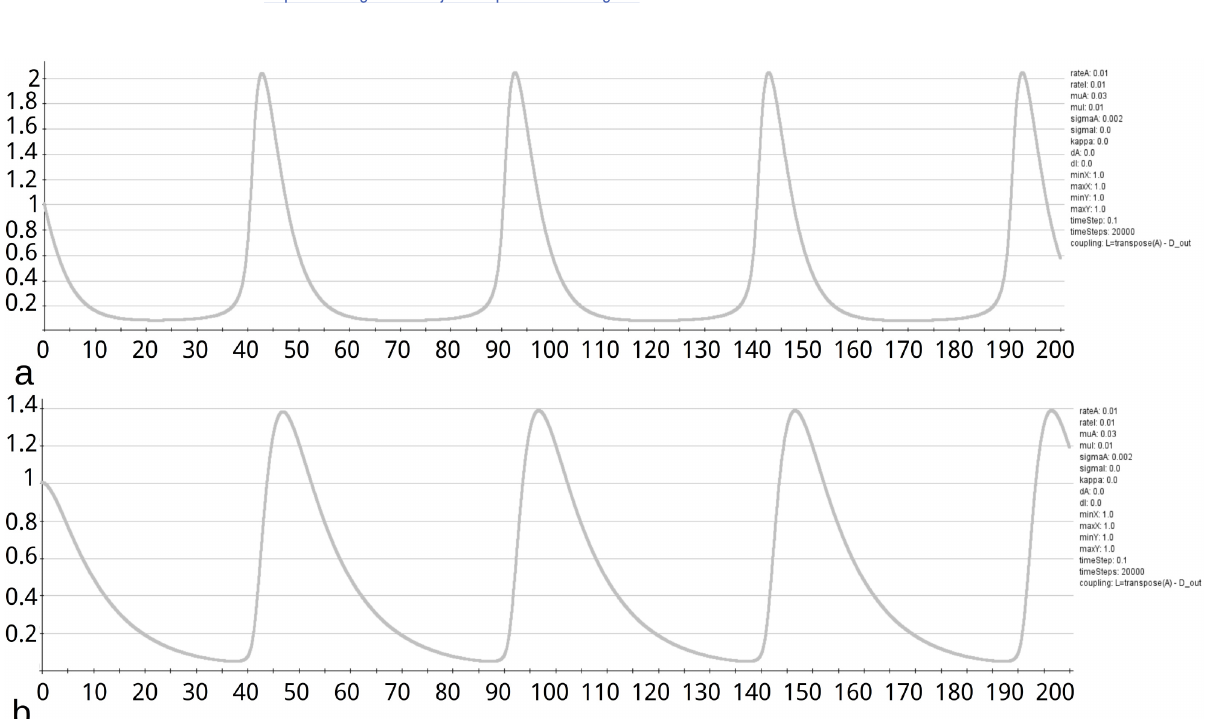
Fig 18. Oscillations of functions u and v . a) In addition to the stability of the function u in Fig 16 the regularity of the oscillations shall be shown here. The regularity extends over all performed iterations. b) The regularity of the oscillations of the function v is shown here. As with the function u , the regularity extends over all iterations